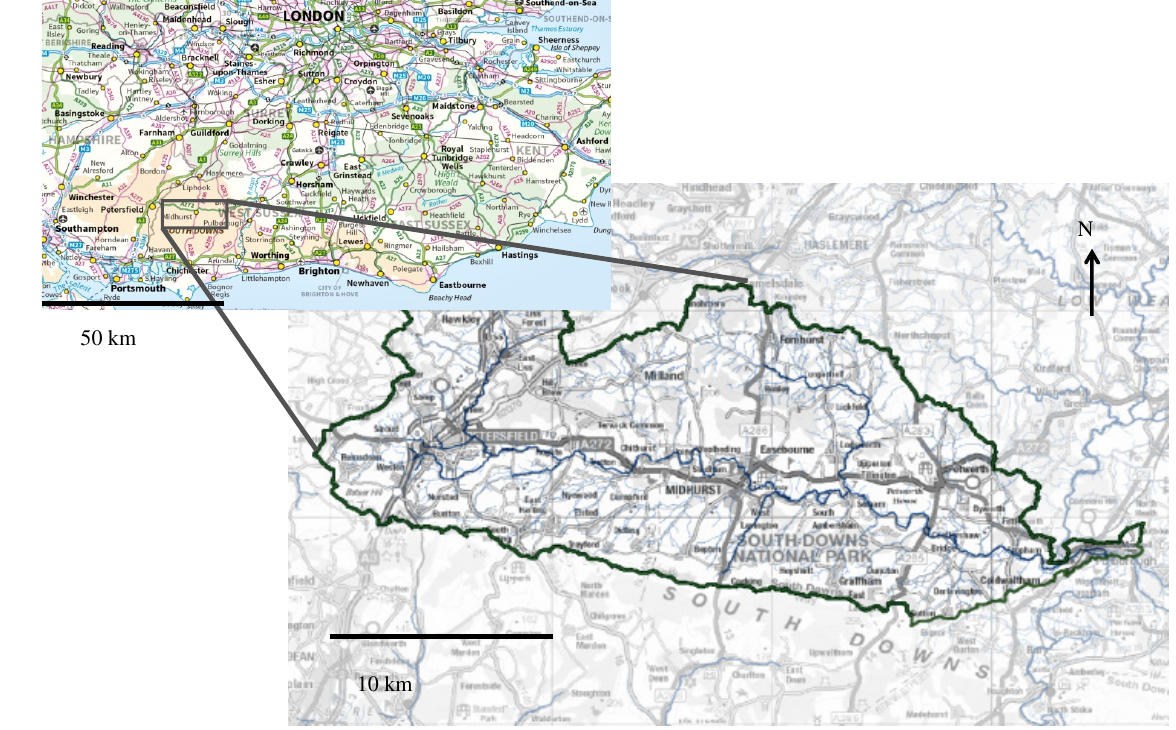
Figure 1. River Rother Catchment is located in the South Downs National Park with Midhurst at the centre (Edina Digimap, 2014; South Downs National Park Authority, 2015).